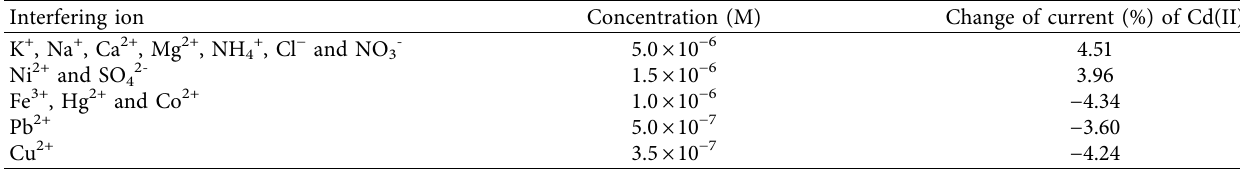
Table 2: Change in current response of 5.0 × 10 − 8 M Cd(II) in the presence of other ions. Interfering ion Concentration (M)